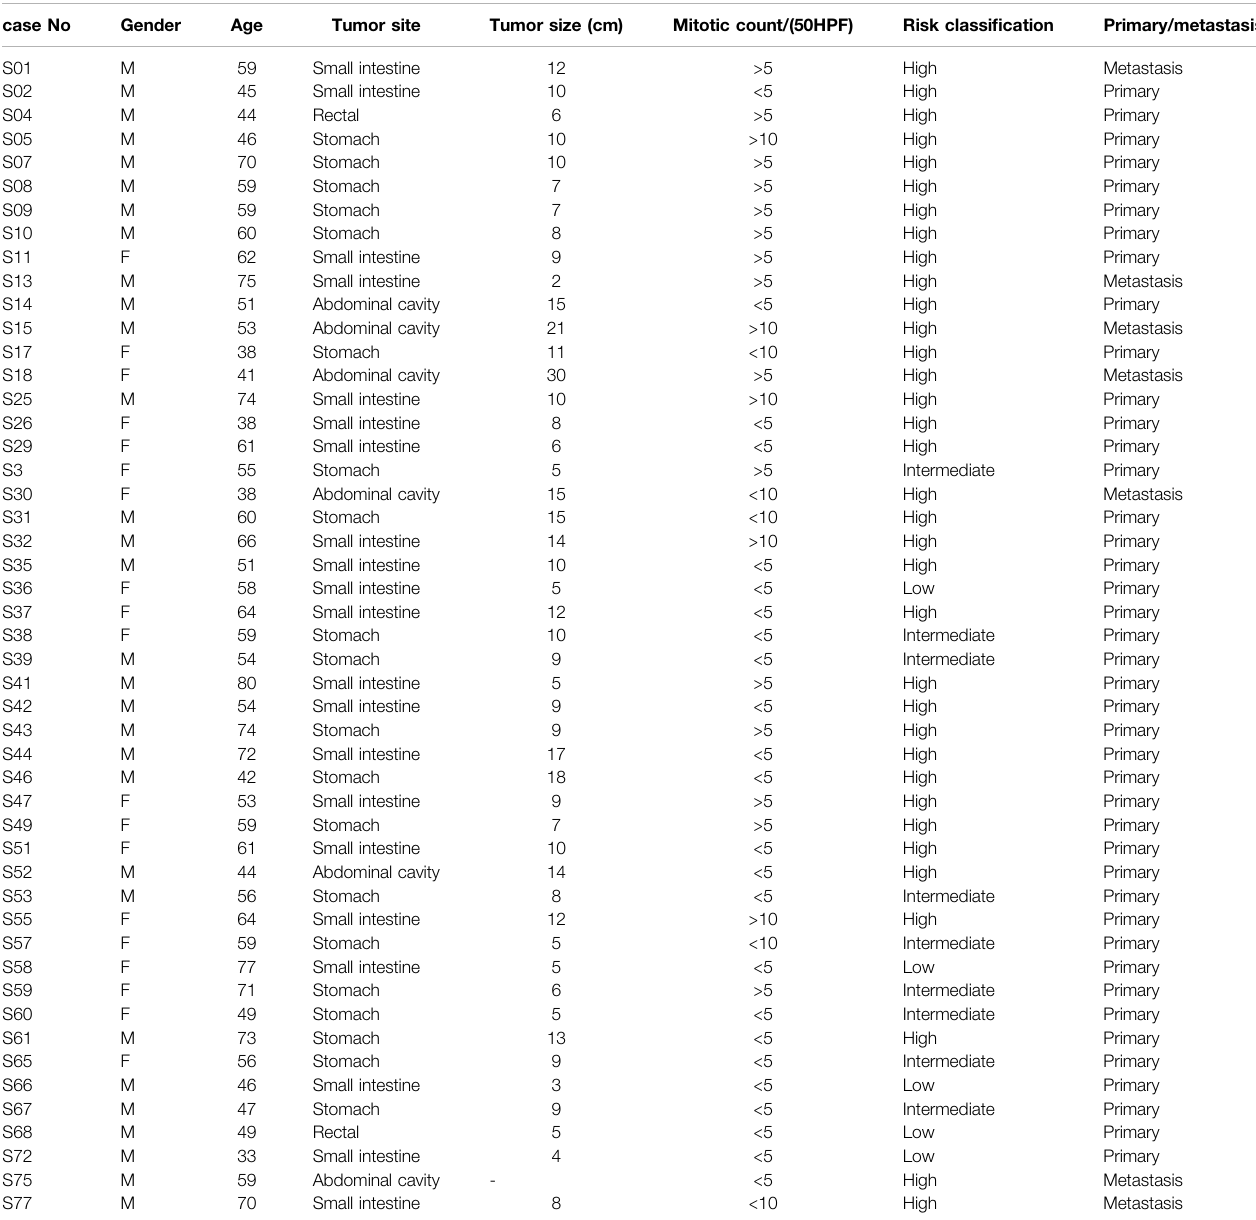
TABLE 1 | Clinical pathological features of 49